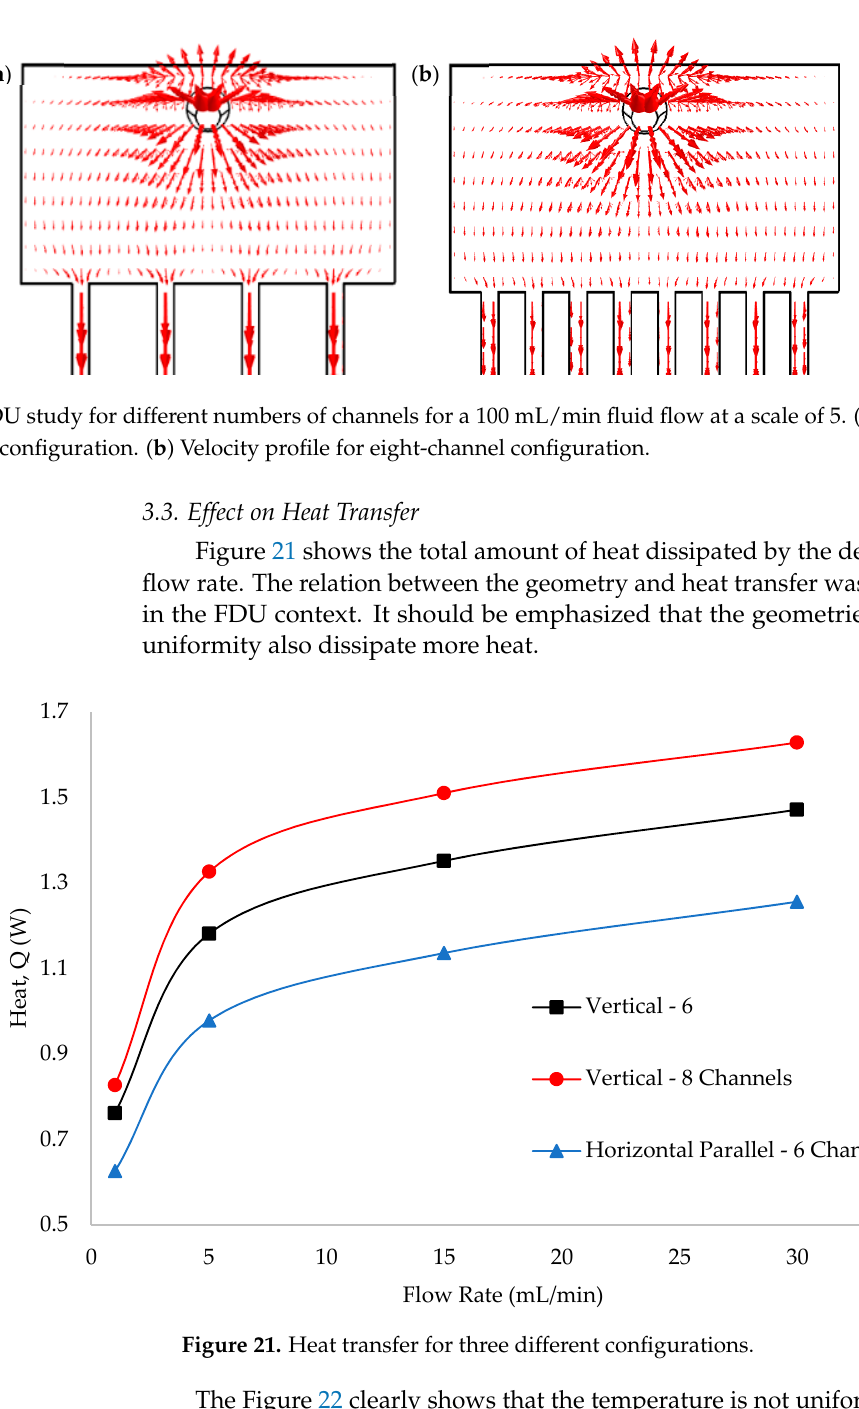
Figure 21. Heat transfer for three different configurations.